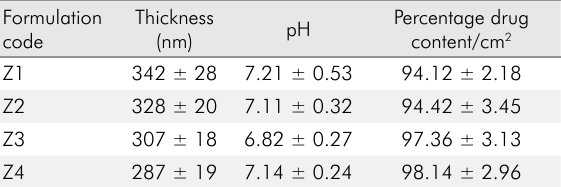
Table 2. Evaluation of thickness, pH and drug content of different buccal films (mean ± SD, n = 6).